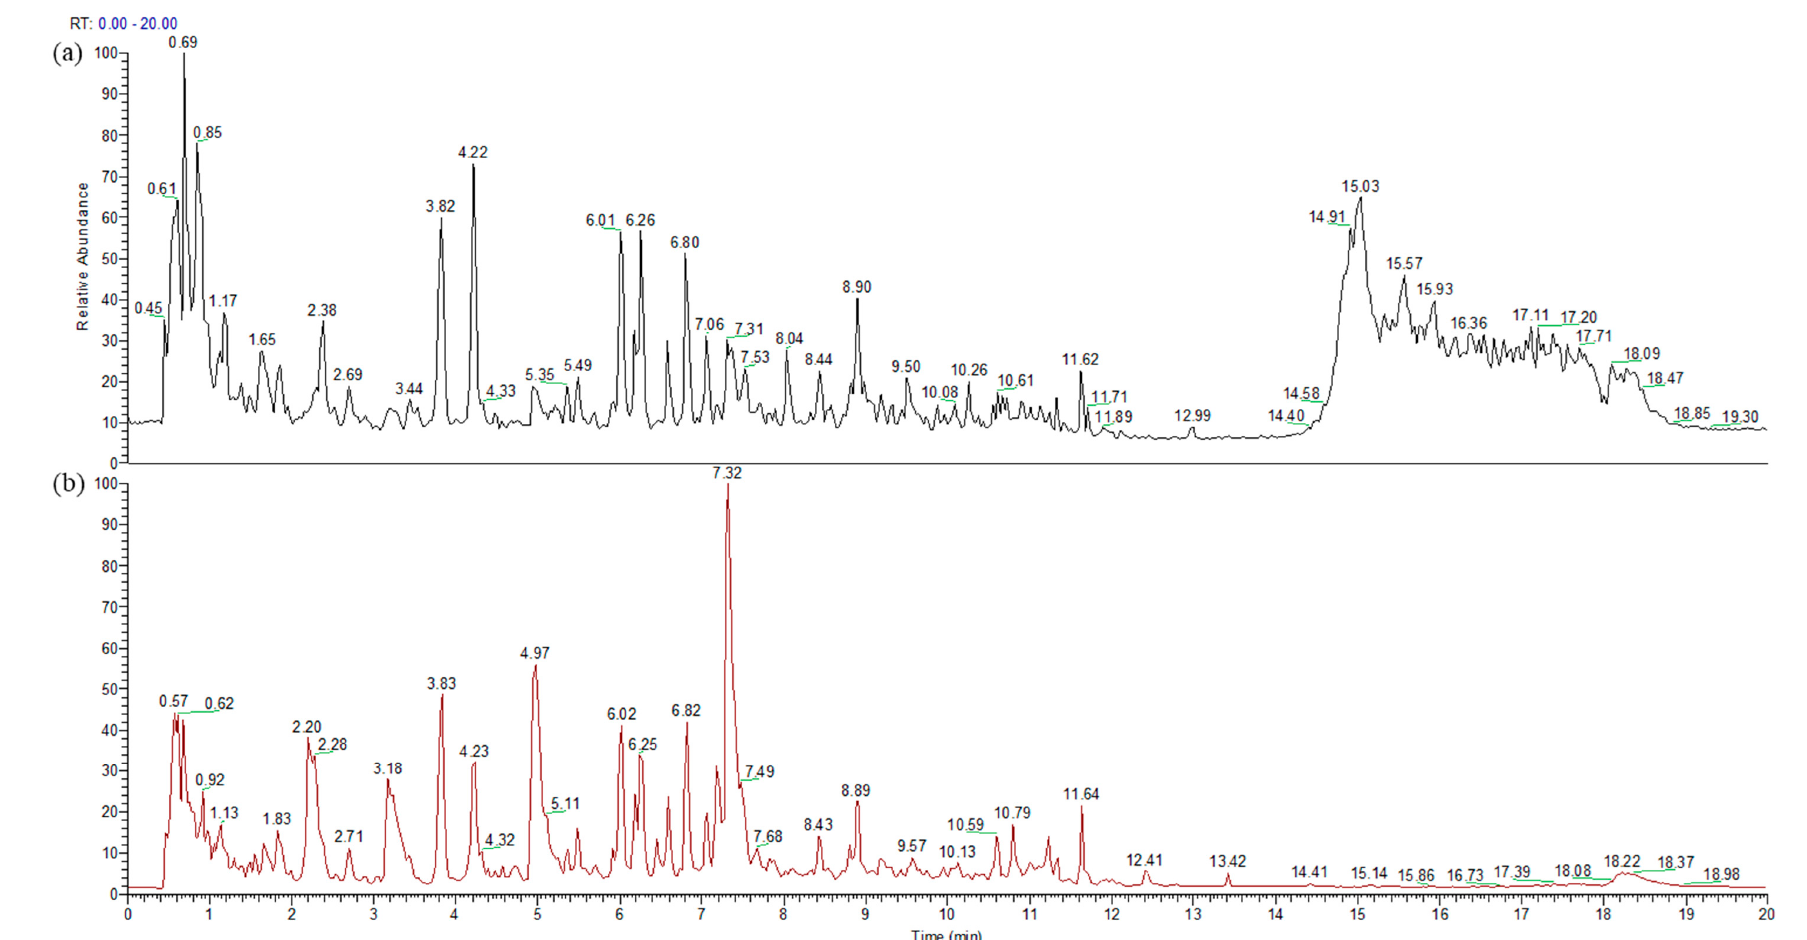
Figure 1. The representative chromatogram on ( a ) positive ionization mode and ( b ) negative ionization mode of one volunteer’s sample.